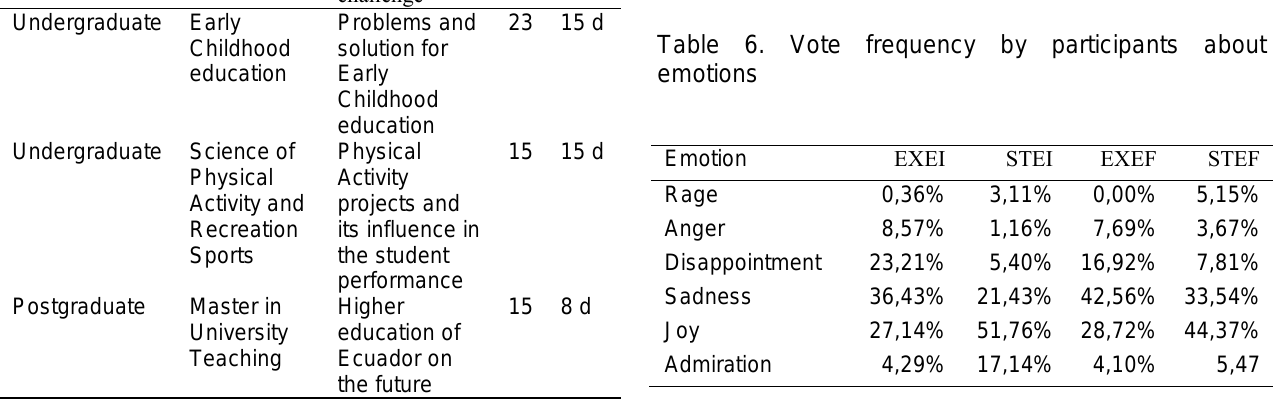
Table 6. Vote frequency by participants about